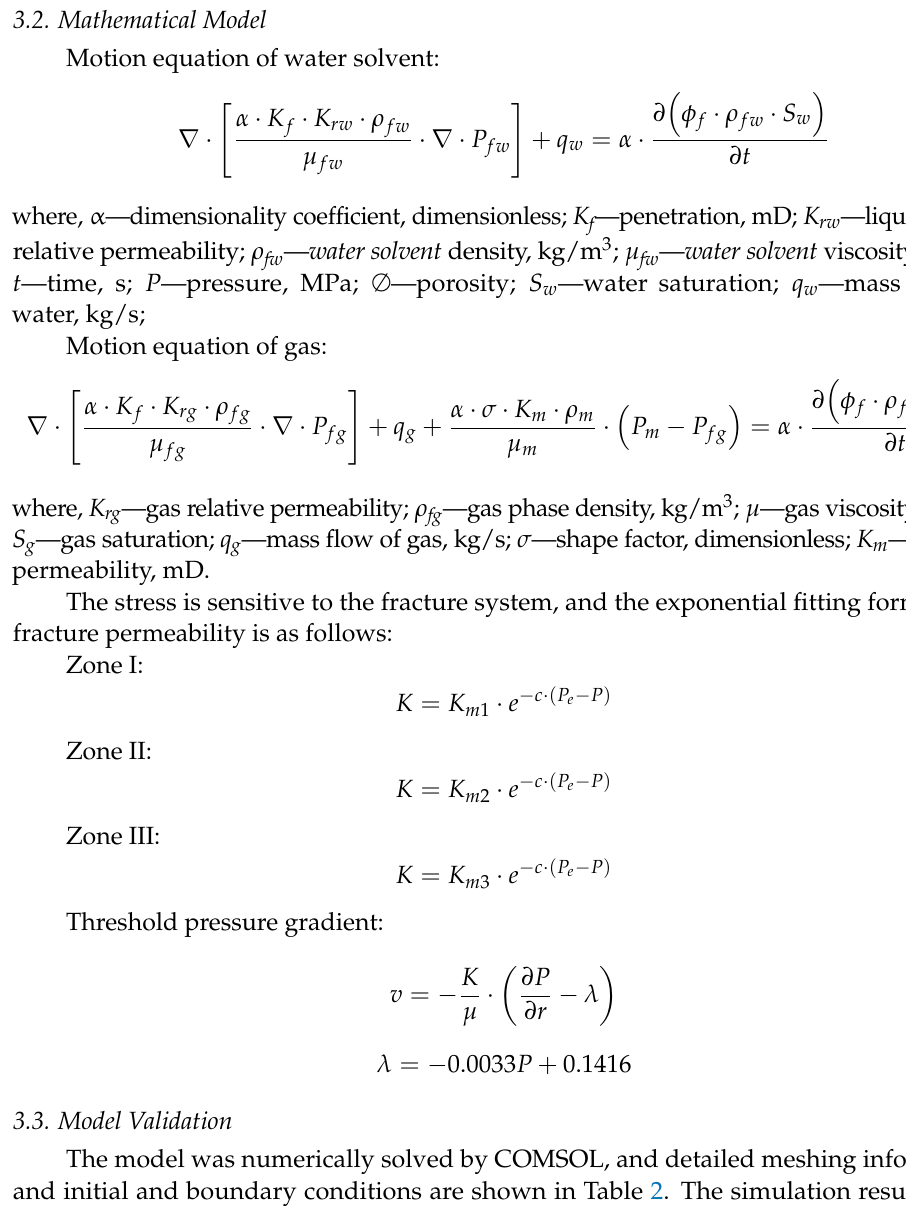
Table 2. Meshing information and initial and boundary conditions.